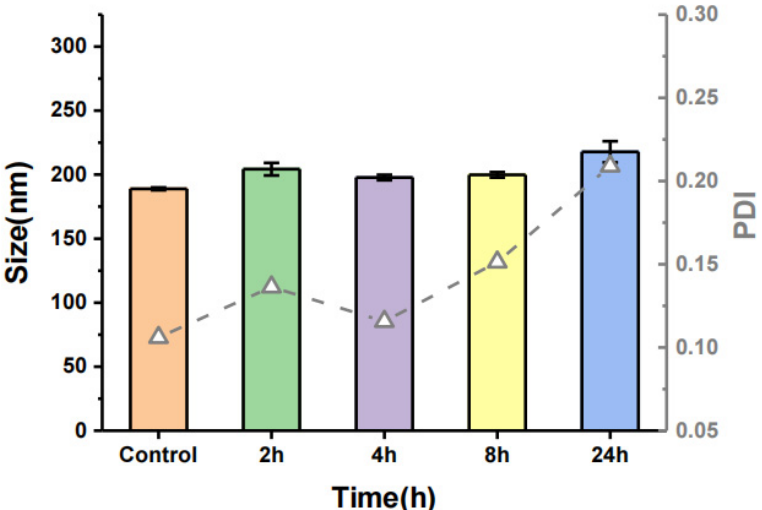
Figure 3. Particle size and PDI of CAS-NEs in the cell culture medium (DMEM) within 24 h; the particle size is represented by bars and PDI by lines.